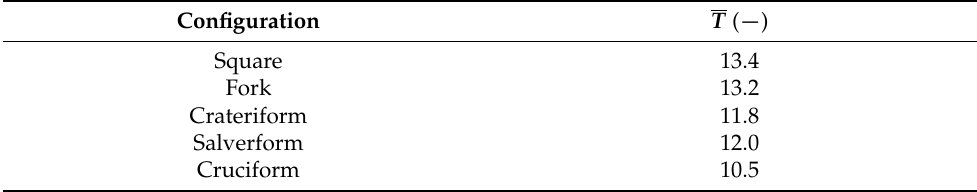
Table 2. Dimensionless temperature for each